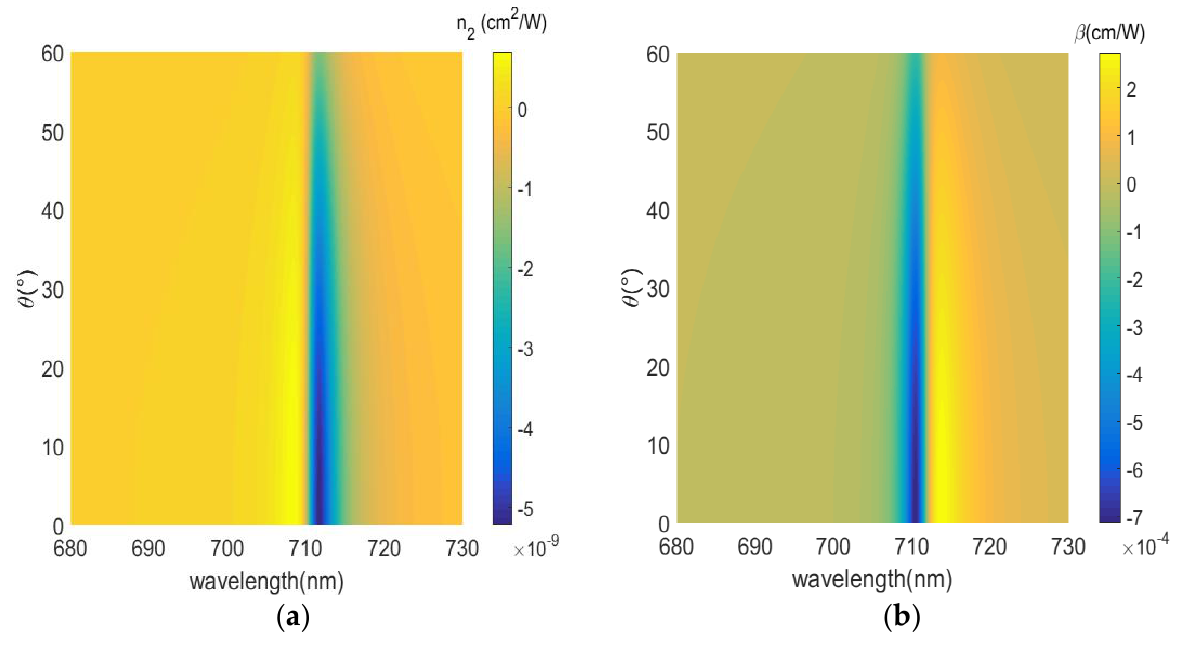
Figure 12. Nonlinear coefficient as a function of incident angle and gain medium concentration (2.5